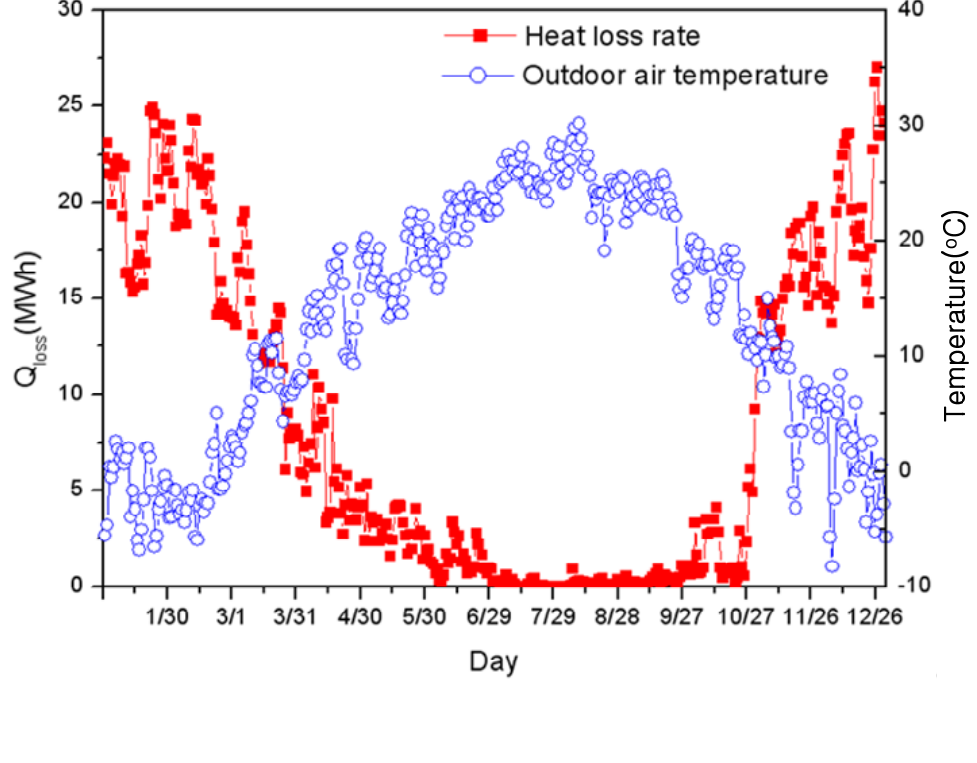
Figure 6. Annual variation of heat loss rate of distribution line of the model apartment and annual variation of outdoor air